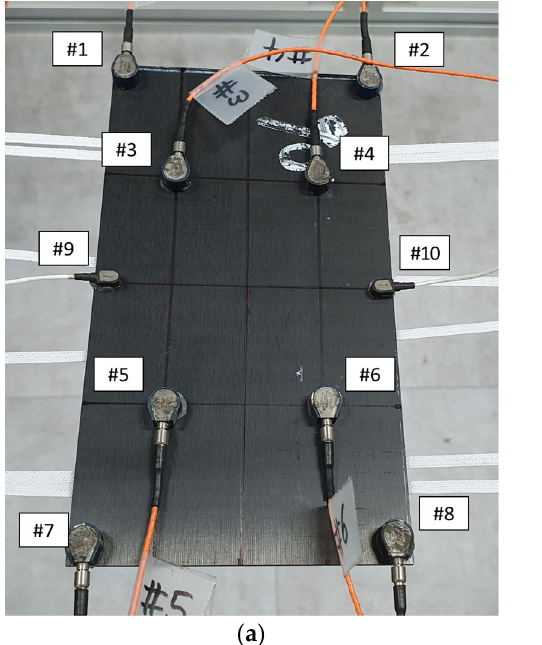
Figure 7. Free–free boundary condition for the experimental modal test: ( a ) UCBC specimen, ( b ) 304SS specimen.